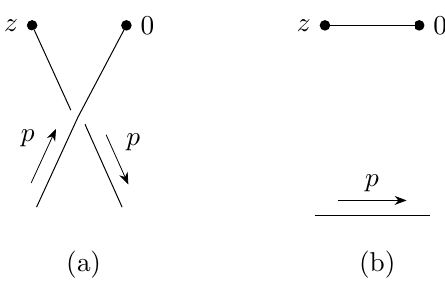
Figure 1 . Contractions that are not considered in the present discussion. Diagram (a) is excluded when considering contributions proportional to exp( (cid:0) ip (cid:1) z ), while diagram (b) cancels when looking at the connected correlator.